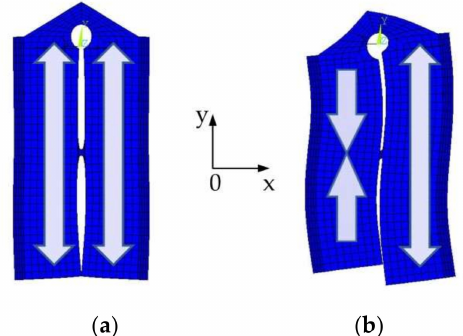
Figure 4. Two working modes with the same longitudinal local modes: ( a ) Rectangular piezoelectric vibrators vibrate with the same phases; ( b ) rectangular piezoelectric vibrators vibrate with the opposite